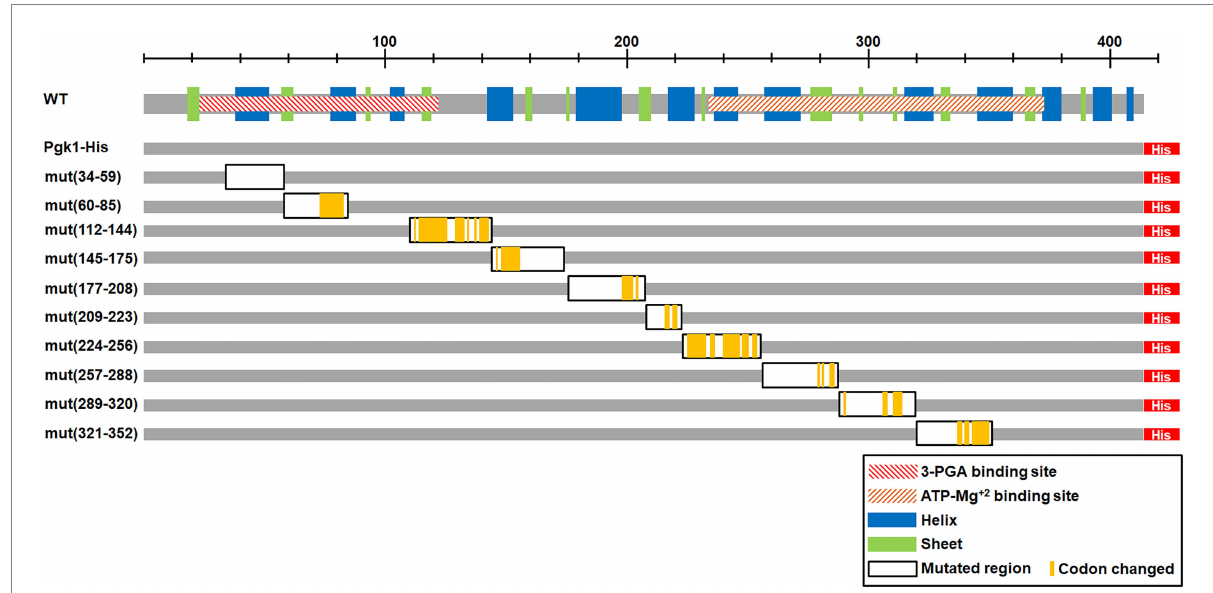
FIGURE 1 Scheme of the mutated regions. The upper scheme presents the Pgk1 protein (in gray). The hatched rectangles indicate the protein domains predicted using the Pfam protein family database [3-phosphoglycerate (3-PGA) binding site and ATP-Mg 2+ binding site]. Blue and green rectangles indicate α helices and β strands, respectively. Lower schemes indicate the different constructions, with the 7xHis tag at the C-terminus (His, red rectangle). The left column indicates the name and position of the mutated codons (WT correspond to the control without mutations, the numbers indicate the mutated region). Black framed rectangles indicate the mutated regions and yellow lines show the actual mutated